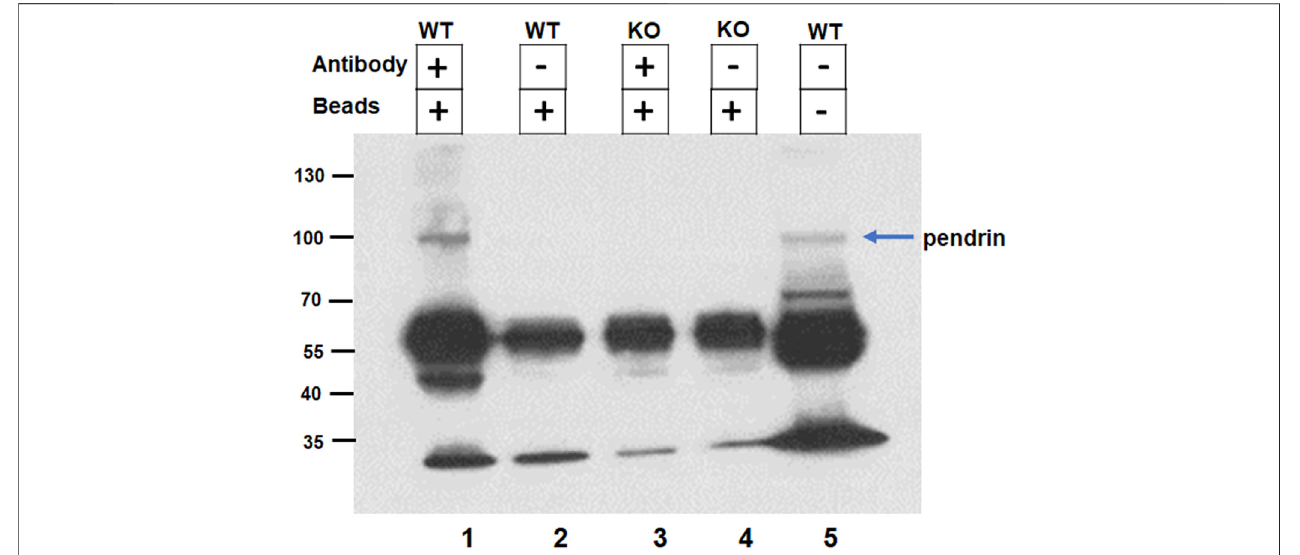
FIGURE 3 | Con fi rmation of IQGAP1 and pendrin interaction by co-immunoprecipitation. The interaction of pendrin with IQGAP1 was con fi rmed by co- immunoprecipitation. Kidney extracts from wildtype and pendrin knockout animals were incubated with IQGAP1 antibody coated beads, the bound proteins were eluted, size fractionated and subjected to western blot analysis using anti-pendrin antibody. Lane 1) Binding of WT kidney extract with IQGAP1 antibody coated beads; Lane 2) Binding of WT kidney extract with G-protein coated beads; Lane 3) Binding of pendrin KO kidney extract with IQGAP1 coated beads; Lane 4) Binding of pendrin KO kidney extract with G-protein coated beads; and Lane 5) WT whole kidney extract. Blue arrow designates the 110 kDa band recognized by anti-pendrin